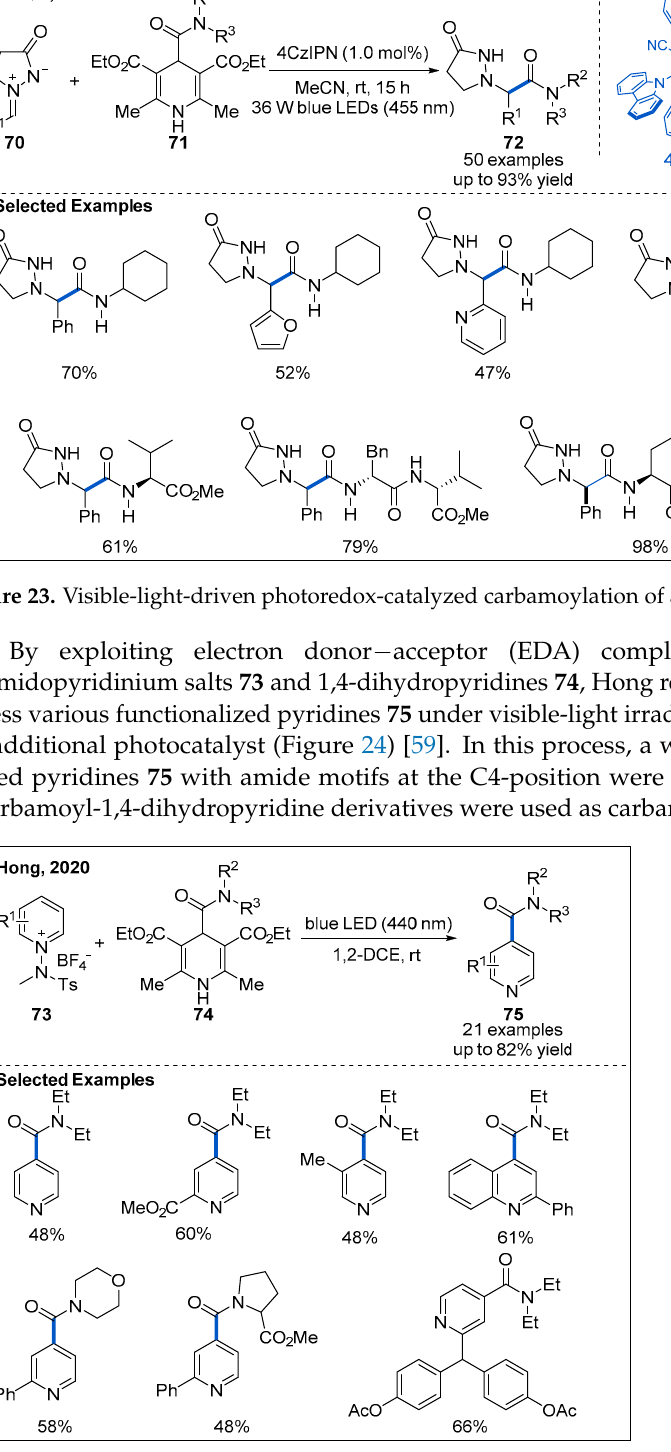
Figure 24. Photoinduced electron donor − acceptor (EDA)-enabled functionalization of pyridinium derivatives with 4-carbamoyl-1,4-dihydropyridines.